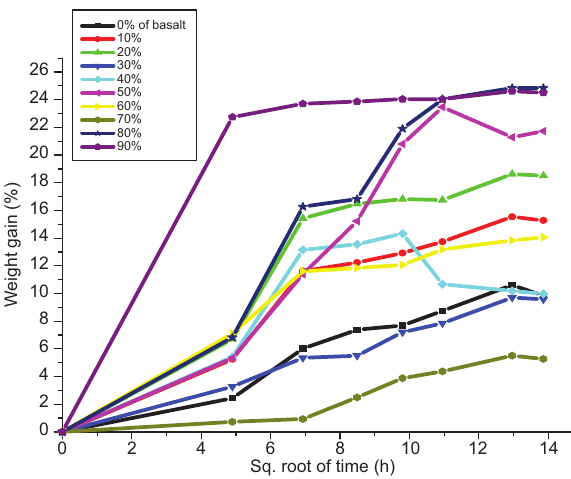
Figure 9 Effect of water absorption of short basalt and jute fiber